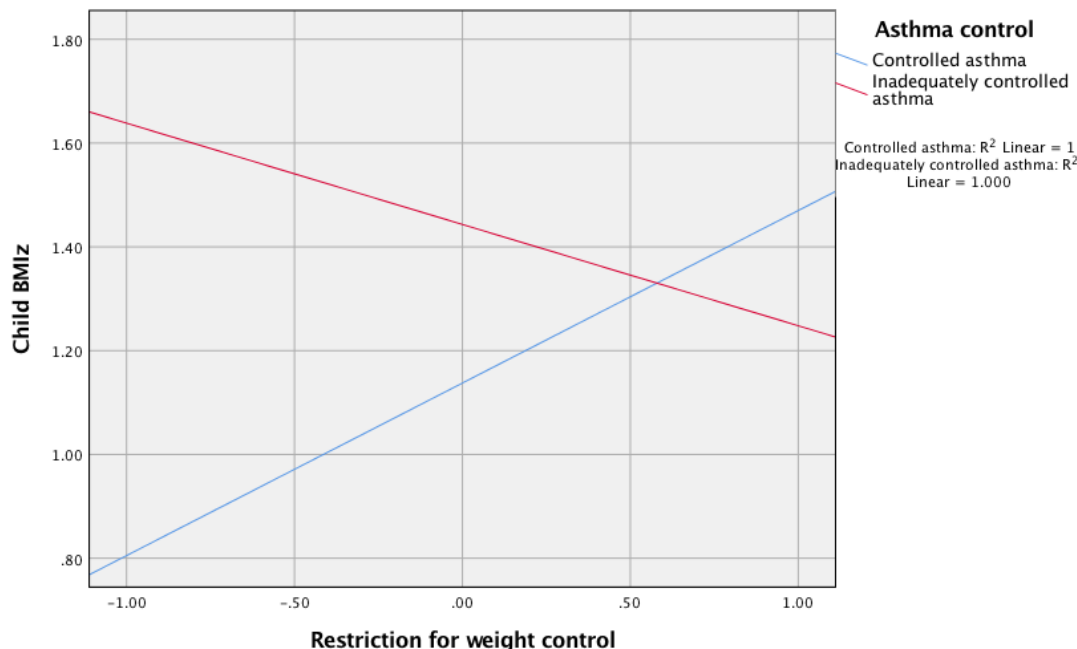
Figure 1. The relationship between parental restriction for weight control and child BMIz score moderated by asthma control.